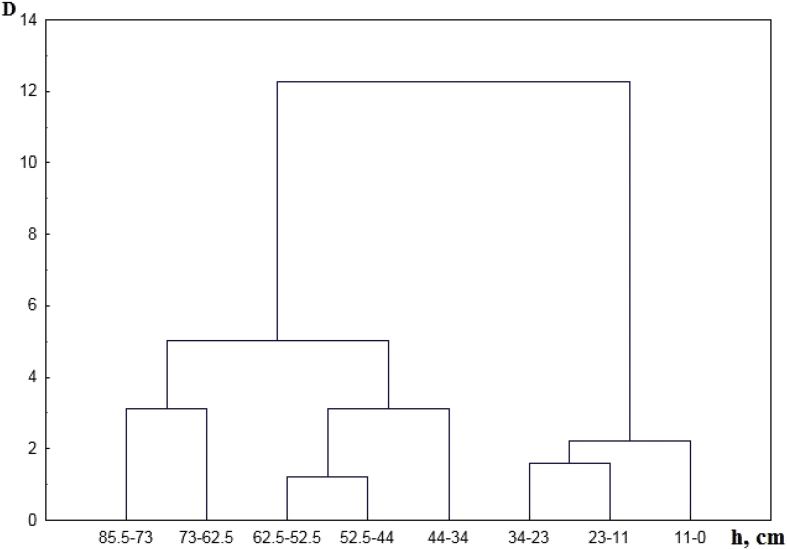
The results of cluster analysis by the values of 10 geochemical coefficients in the layers of pedosediments (2019).